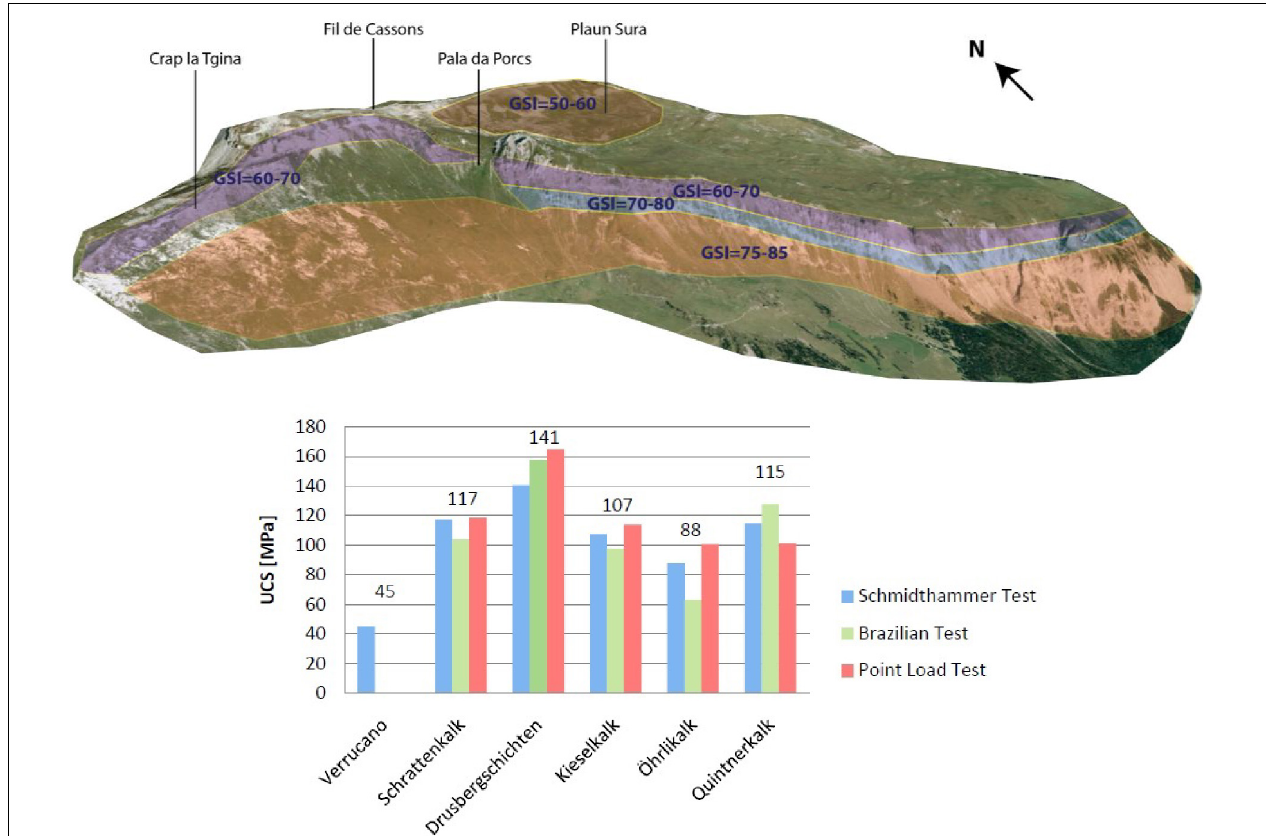
FIGURE 7 | Top: GSI (Geological Strength Index) domains in the study area, based on outcrop-scale field observations. The GSI generally increases with depth in the sequence (Imagery: Google Earth, 2009). Bottom: Unconfined compressive strength values derived from different strength testing methods. Mean values from averaging across tests for each lithology are